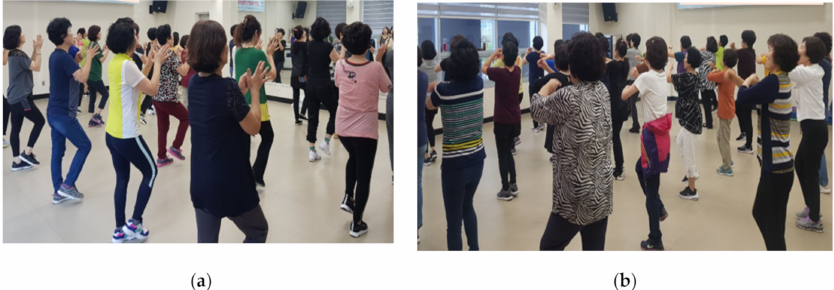
Figure 3. Exercises performed: ( a ) walking while clapping; and ( b ) walking while turning the wrist.